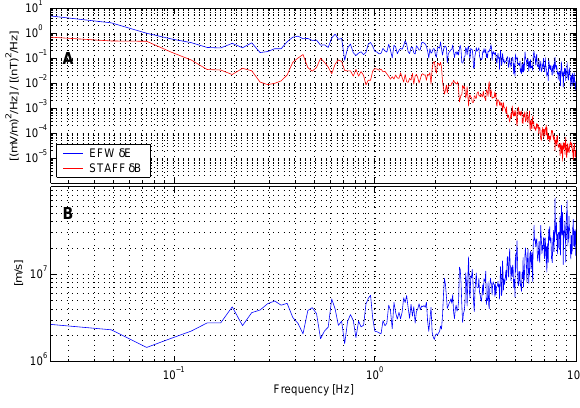
Fig. 2. Panel (a) Power spectral density of the electric and mag- netic field and panel (b) the δE ⊥ /δB ⊥ -ratio for the time interval 02:54:00–02:56:00 UT in the HLBL. In the low frequency limit the δE ⊥ /δB ⊥ -ratio is of the order of the Alfv ´ en velocity (1300– 1500km / s). The proton gyrofrequency was ∼